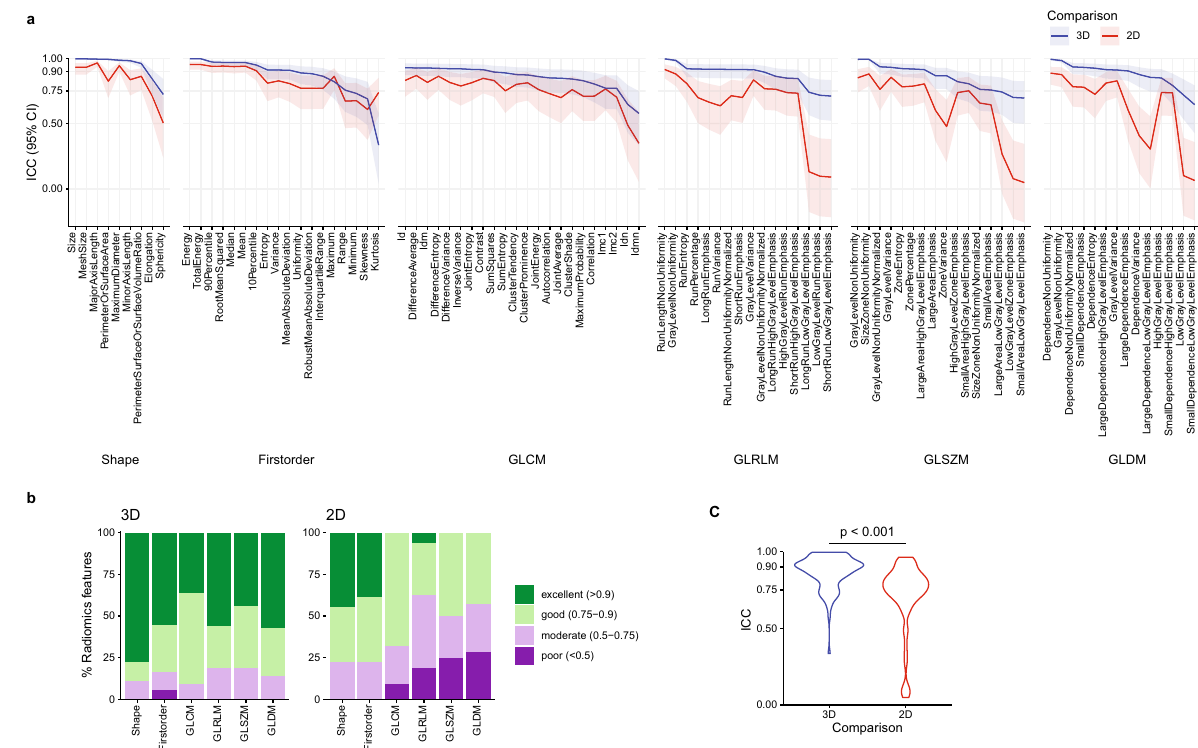
Fig. 3 Reproducibility of 2D and 3D fetal MRI lung radiomics features. a Intra-class correlation coefficients (ICCs) and 95% confidence intervals (CI) between 2 and 3D regions of interest (ROIs) in repeat examinations for each of the 95 investigated features. Lines (ICCs) and ribbons (95% CI) are coloured according to the comparisons depicted (3D blue, 2D red). Features are grouped according to class. b Barplots depicting the proportions of radiomics features with poor (ICC < 0.5), moderate (0.5–0.75), good (0.75–0.9) and excellent (> 0.9) reproducibility according to feature class and 2D or 3D ROIs in repeat examinations. c Radiomics feature ICCs were significantly higher between initial and repeat MRI acquisitions if 3D ROIs were used for radiomics feature extraction compared to 2D ROIs; CI confidence interval GLCM: grey level co-occurrence matrix, GLDM: grey level dependence matrix, GLRLM: grey level run length matrix, GLSZM: grey level size zone matrix, ICC intra-class correlation coefficient